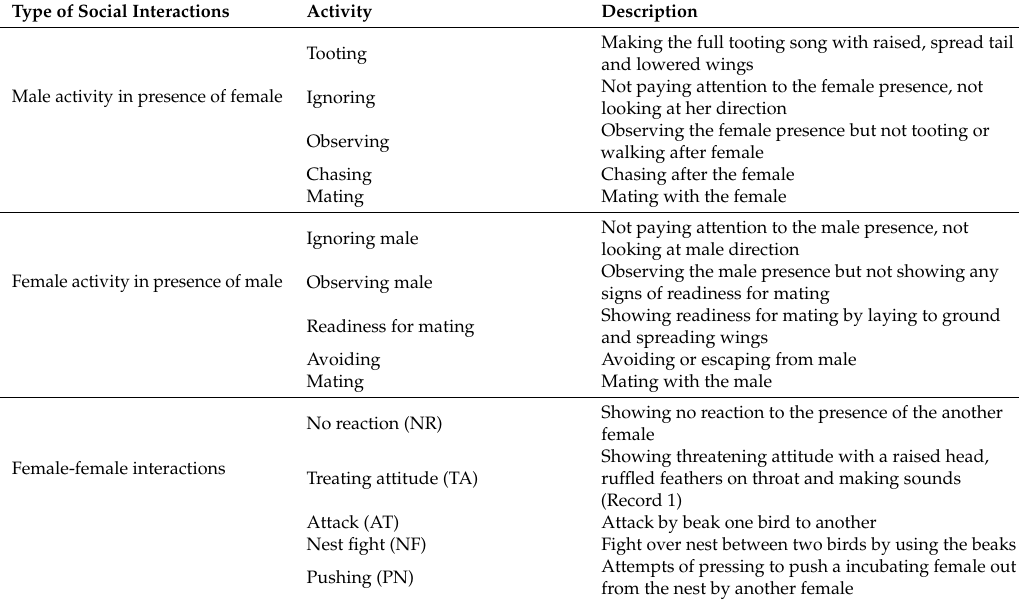
Table 1. Ethogram for observed Capercaillie social behaviors in Capercaillie Breeding Centre in Wisła Forestry